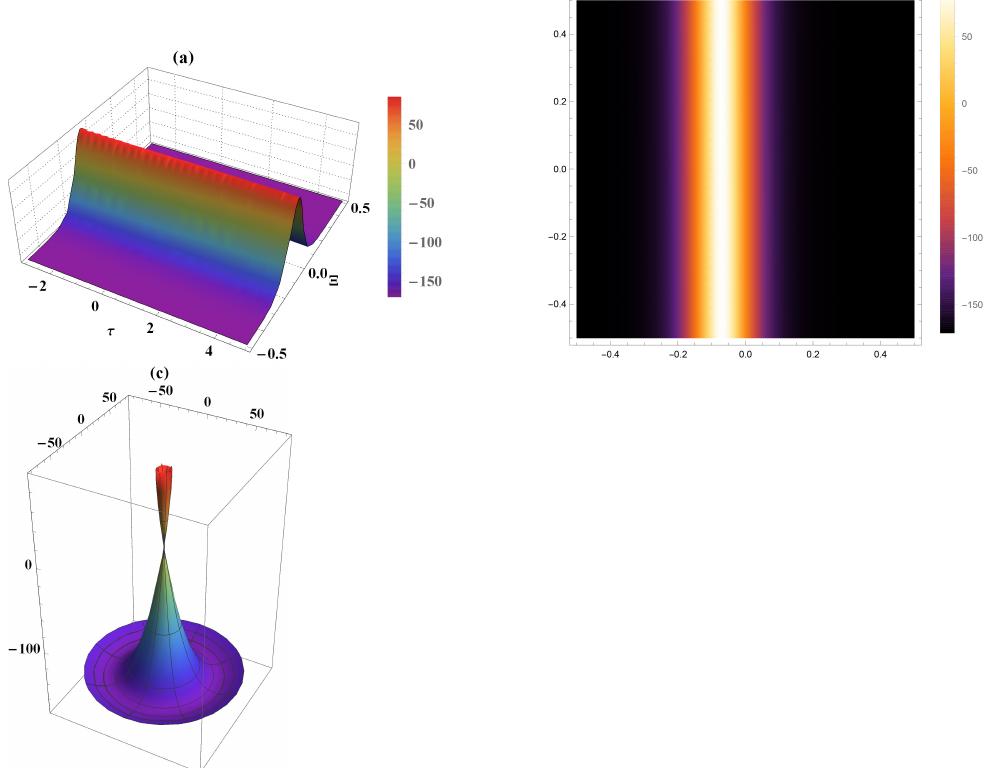
Figure 1. Bright solitary wave solution of Equation (12) in ( a ) three–dimension, ( b ) density and ( c ) spherical plot three–dimensional for h 1 = − 4, h 3 = 32, ϑ = 5, (cid:36) =